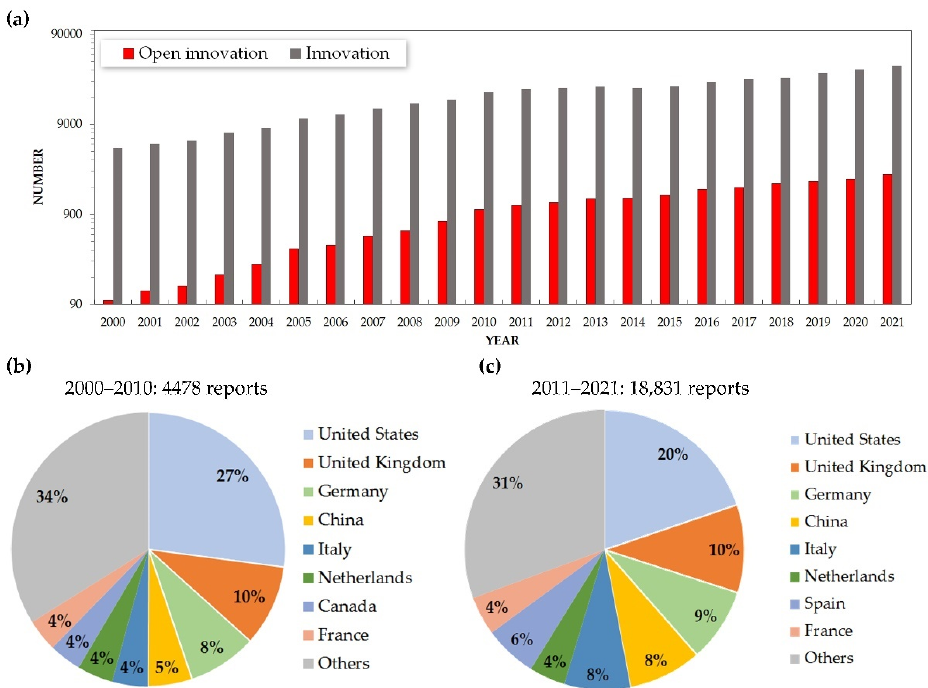
Figure 1. The publications in journals indexed in Scopus database for 2000–2021 period; a search was performed with “open innovation” and ‘’innovation’’ keywords: ( a ) the annual distribution of publications over the years; ( b , c ) the percentage distribution of country affiliations for the publications with “open innovation” keyword in 2000–2010 ( b ) and 2011–2021 ( c ). Sharper dynamics are observed in China and Italy in terms of the number of publi- cations and their share. In China, the share increased to ca. 9% in 2010–2021, compared to ca. 5% in 2000–2010; the number of publications increased by 6.8 times. In Italy, the share reached ca. 8% in 2011–2021, compared to ca. 4% in 2000–2010; the number of publications increased by 7.5 times. Obviously, the noted trends have been promoted by a general global tendency to support research in this direction. Such global dynamics suggest that open innovations find increasing interest in the academic society due their potential as a field of research.